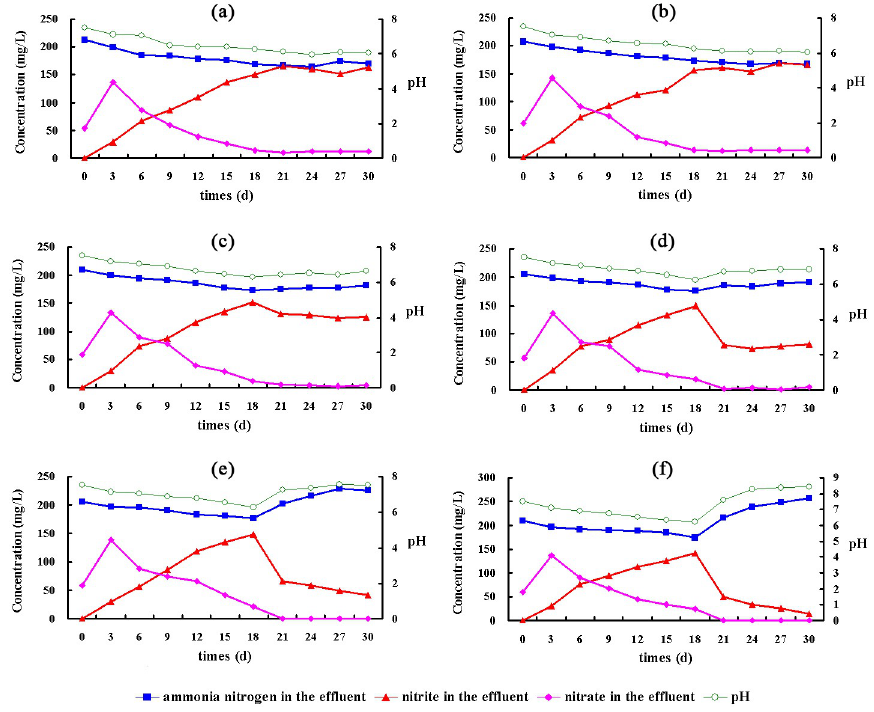
Fig 1. Ammonia nitrogen, nitrite and nitrate concentrations in all systems. (a) Control group, (b) Nano group, (c) Tet group, (d) Ery group, (e) Nano&Tet group, (f) Nano&Ery group.